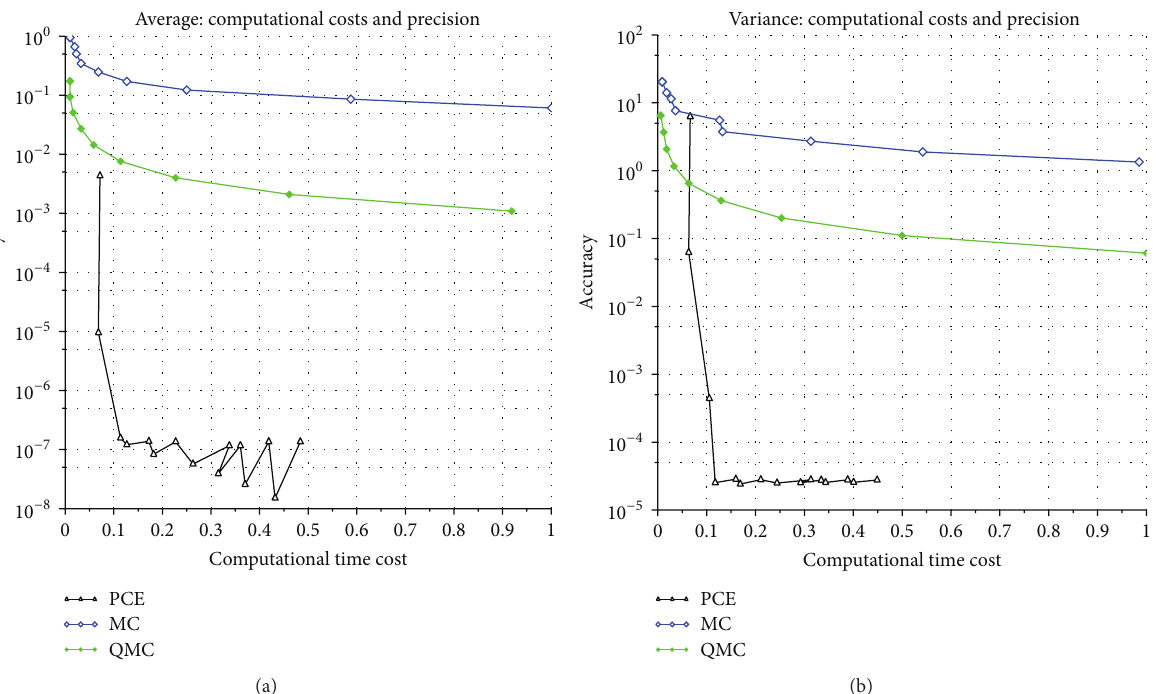
Figure 19: Semilogy scale plot which compares the accuracy and computational time costs for detecting the average (a) and variance (b) of the GBM by means of PCE, MC, and QMC approaches. The parameters of the GBM equity model are 𝑟 = 3 %, 𝜎 = 15 %, 𝑇 = 1 , and 𝑆 0 = 100